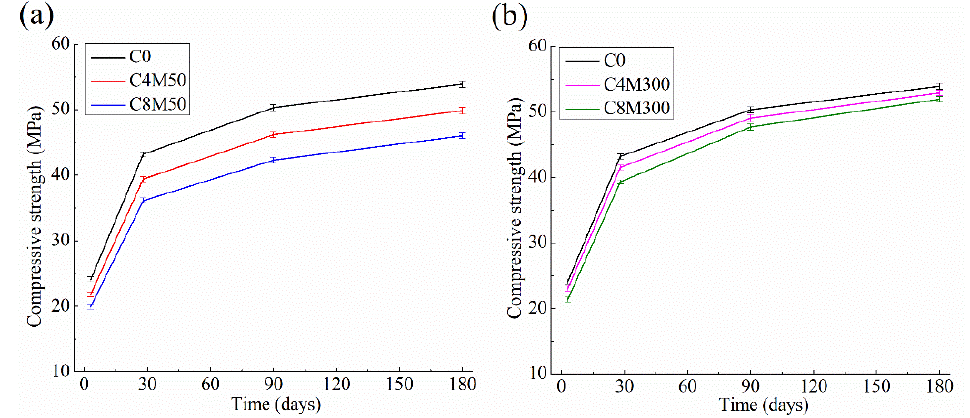
Figure 1. Compressive strength of concrete containing MgO with reactivity of ( a ) 50 s and ( b ) 300 s.